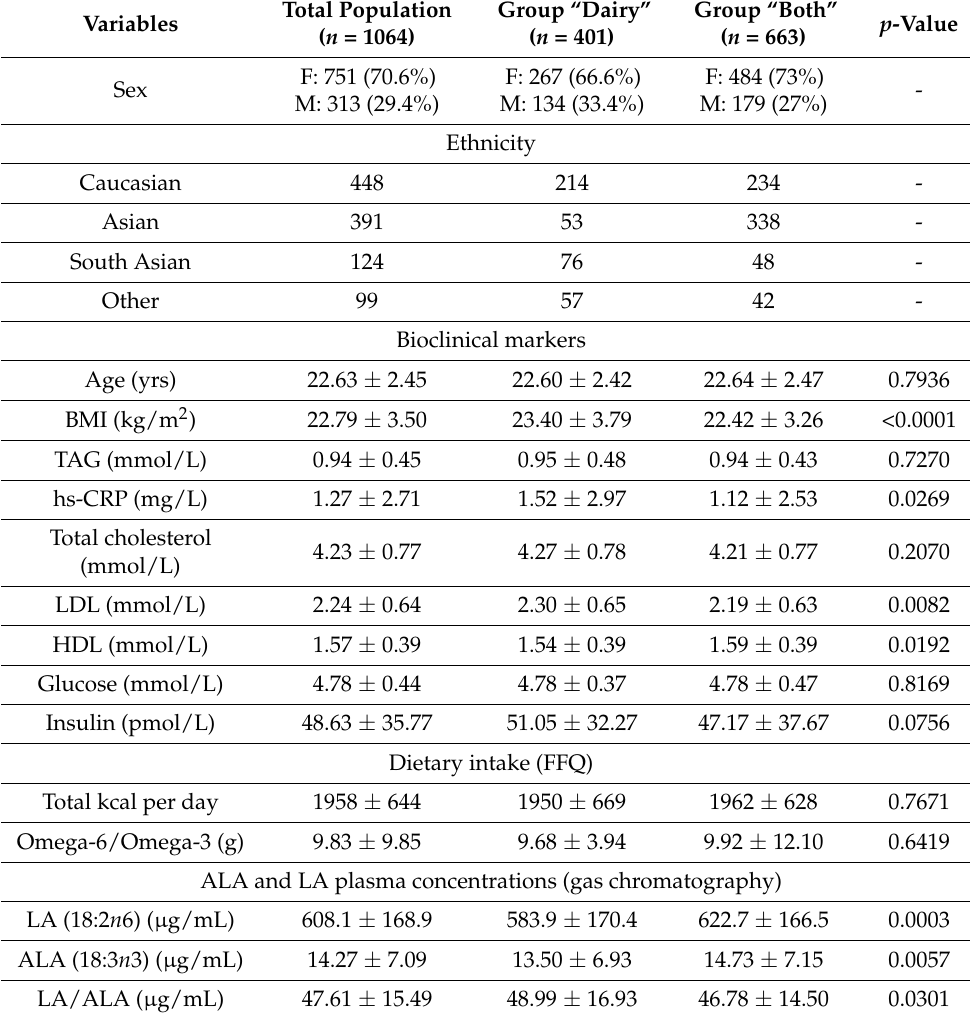
Table 3. General characteristics of the population by total dairy and total soy intake 1 .